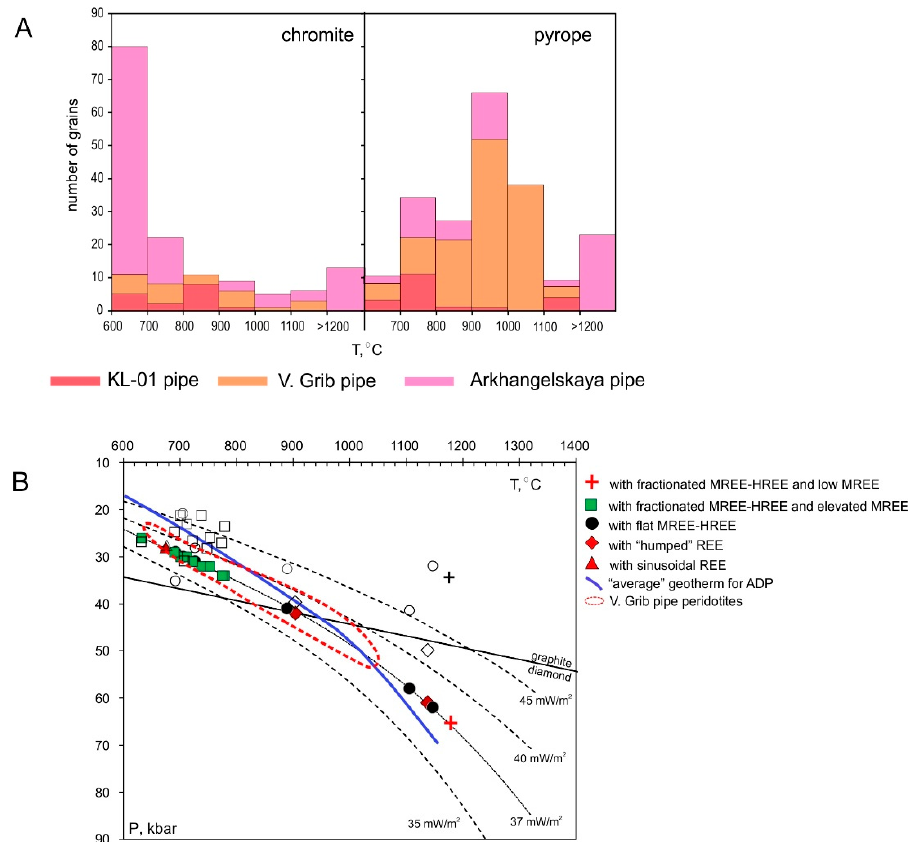
Figure 15. P-T estimates for the KL-01 pipe xenocrysts. ( A ) Distribution of estimated temperature [35] for pyrope and Cr-spinel xenocrysts from the KL-01 pipe. Pyrope xenocrysts from the V. Grib kimberlite pipe pyropes [33]; pyropes and Cr-spinel xenocrysts from the Arkhangelskaya pipe [16]; Cr-spinel xenocrysts from the V. Grib kimberlite pipes (Tables S5-1 in Supplementary Material). ( B ) P-T estimates for pyrope xenocrysts from the KL-01 pipe. Colored symbols—projecting of T values [35] onto 37 mW/m 2 geotherm; black-white symbols—P-T values obtained using the method of [35]. V. Grib pipe peridotites [32]; “average” geotherm for ADP [64]. Geotherms from [65].